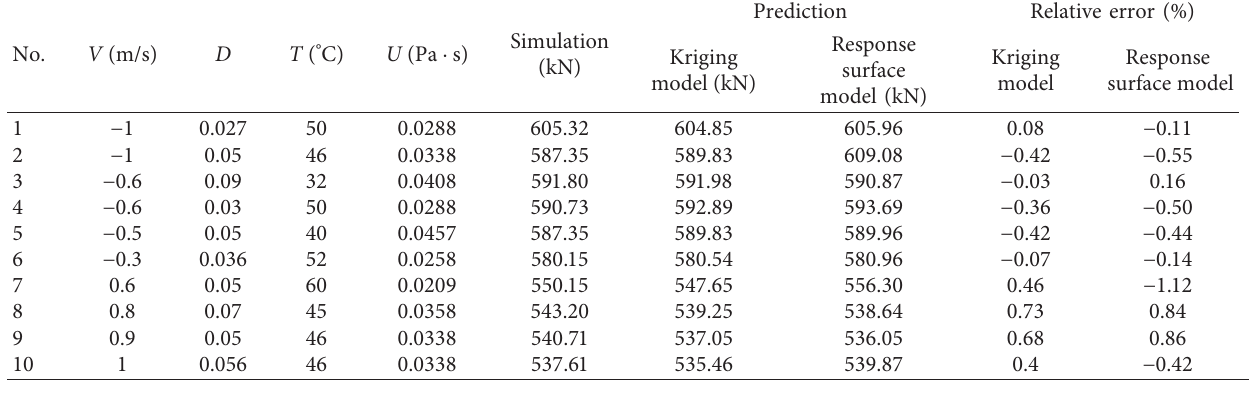
Table 8: Stiffness force